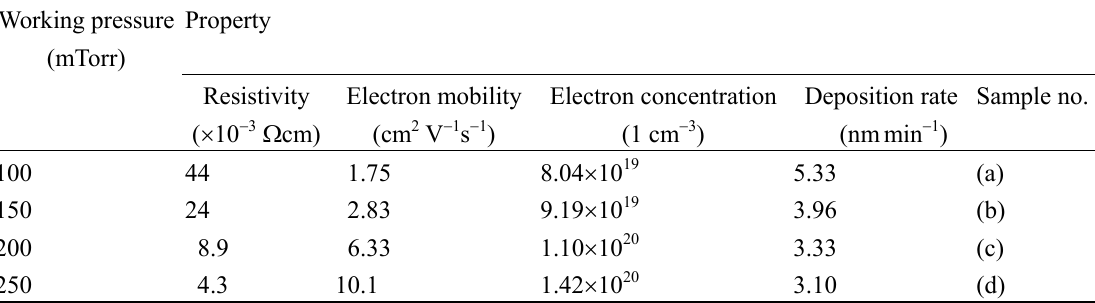
Table 1. Resistivity, electron mobility, electron concentration and deposition rate of ZnO films deposited on Si substrates at 100W rf power and 20 sccm Ar flow rate with various working pressures. Reprinted from [19] with permission.